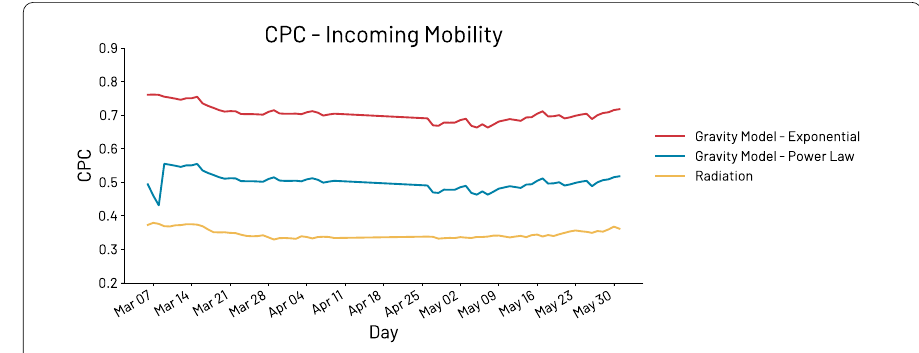
Figure 3 CPC related to incoming mobility of the radiation model (in yellow), of the gravity model with an exponential decay (in red), and of the gravity model with a power-law decay (in blue). The model performing better is the gravity model with exponential decay, and this is valid both before and during the introduction of non-pharmaceutical interventions due to the COVID-19 pandemic. In particular, the gravity model with exponential decay reaches an average CPC of 0.762 before the introduction of non-pharmaceutical interventions, 0.666 during the introduction of non-pharmaceutical interventions, and 0.685 over the entire period under analysis